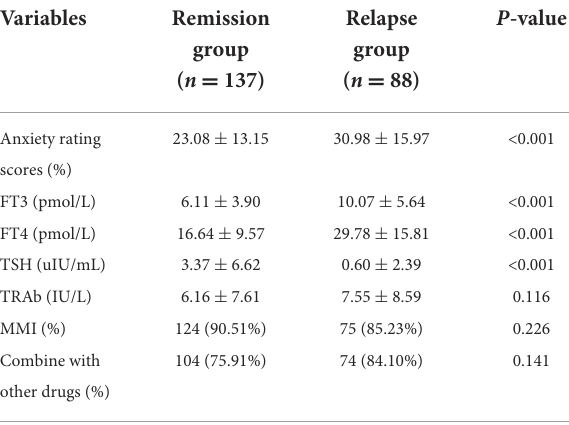
TABLE 3 Laboratory baseline of patients in the drug reduction group.